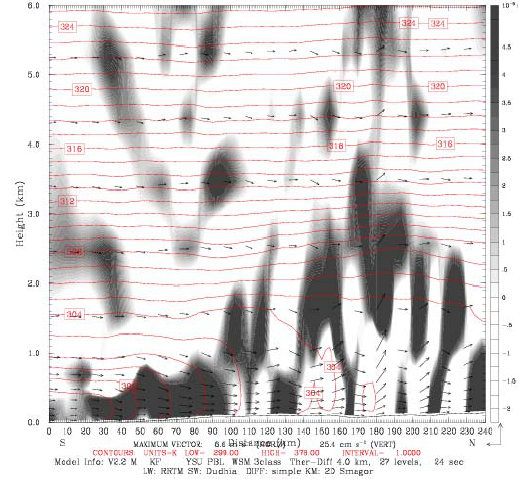
Figure 11: Vertical section of Potential temperature (K) and circulation vectors (ms -1 ), divergence (1.0e-05 s -1 ) and vertical motion (s -1 ) for a south-north vertical-section at 1600 LT on June 28, 2007.